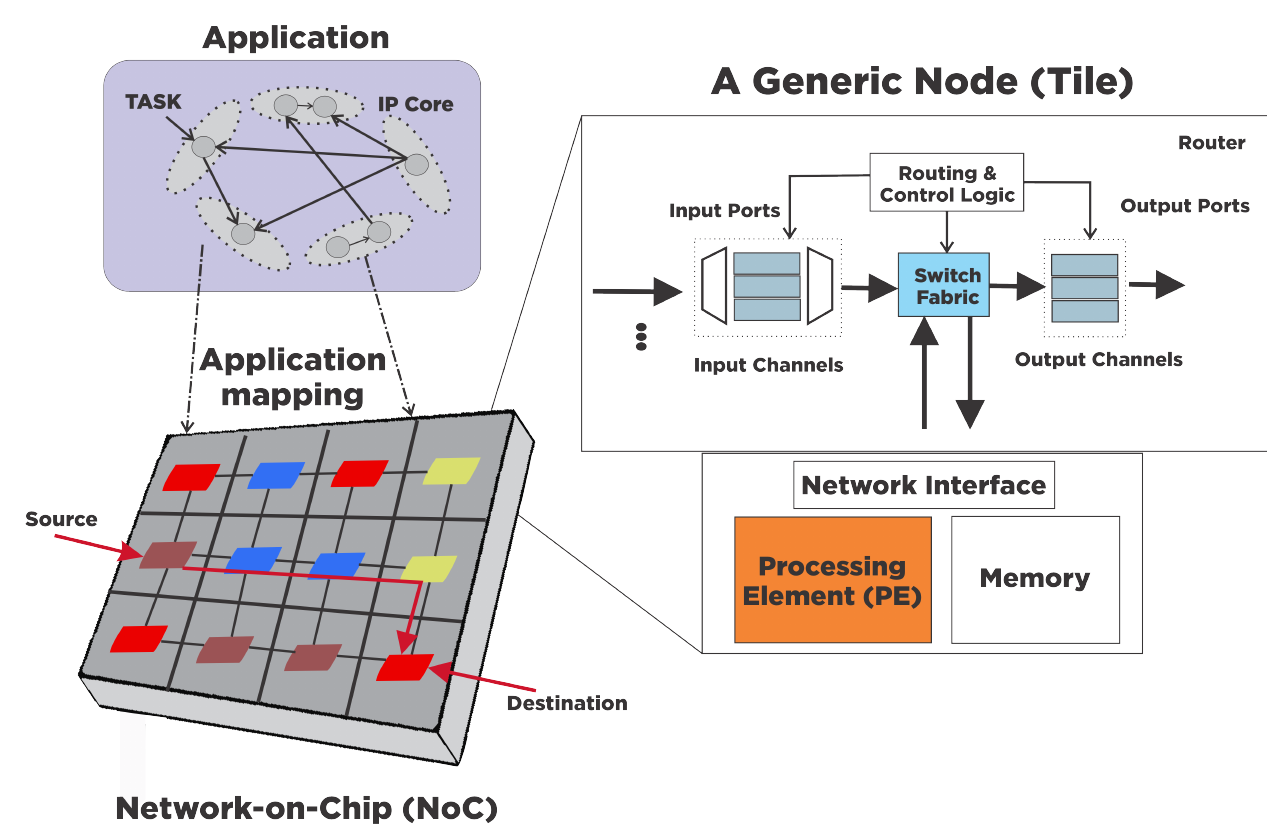
Figure 1. NoC architecture, application, and its mapping to the NoC. The micro-architecture of a node, which consists of an on-chip router, buffers, and processing element (PE), is also shown on the right-hand side of the figure